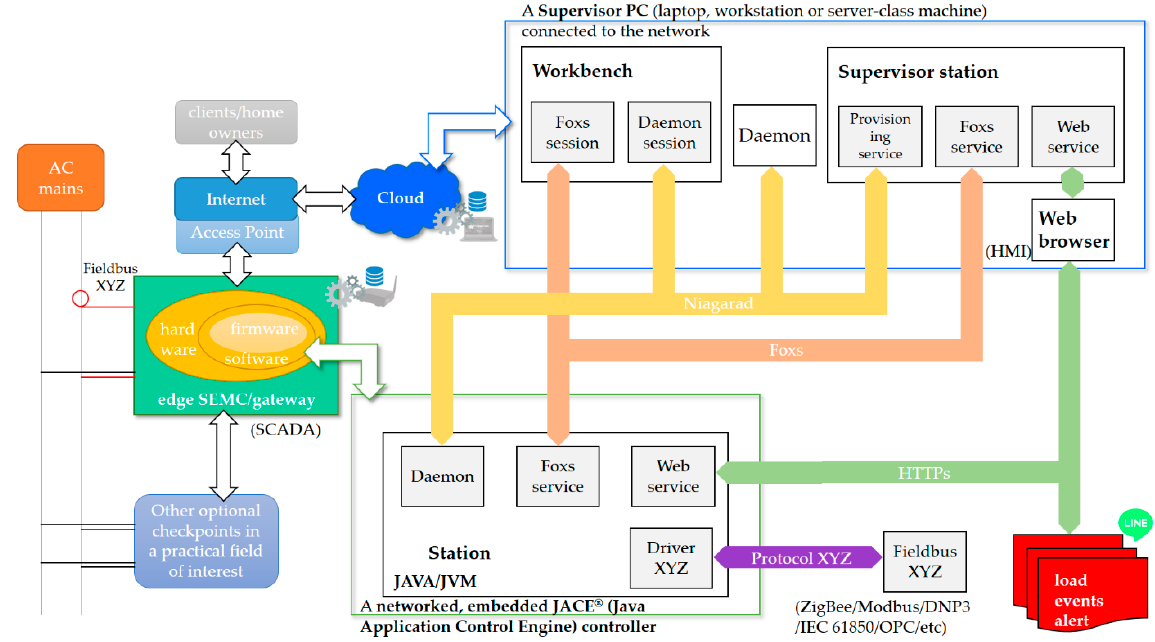
Figure 4. Configuration of the Niagara Framework ® that considers a supervisor PC/laptop and a single-networked, embedded JACE ® controller for SHEMS in this study.